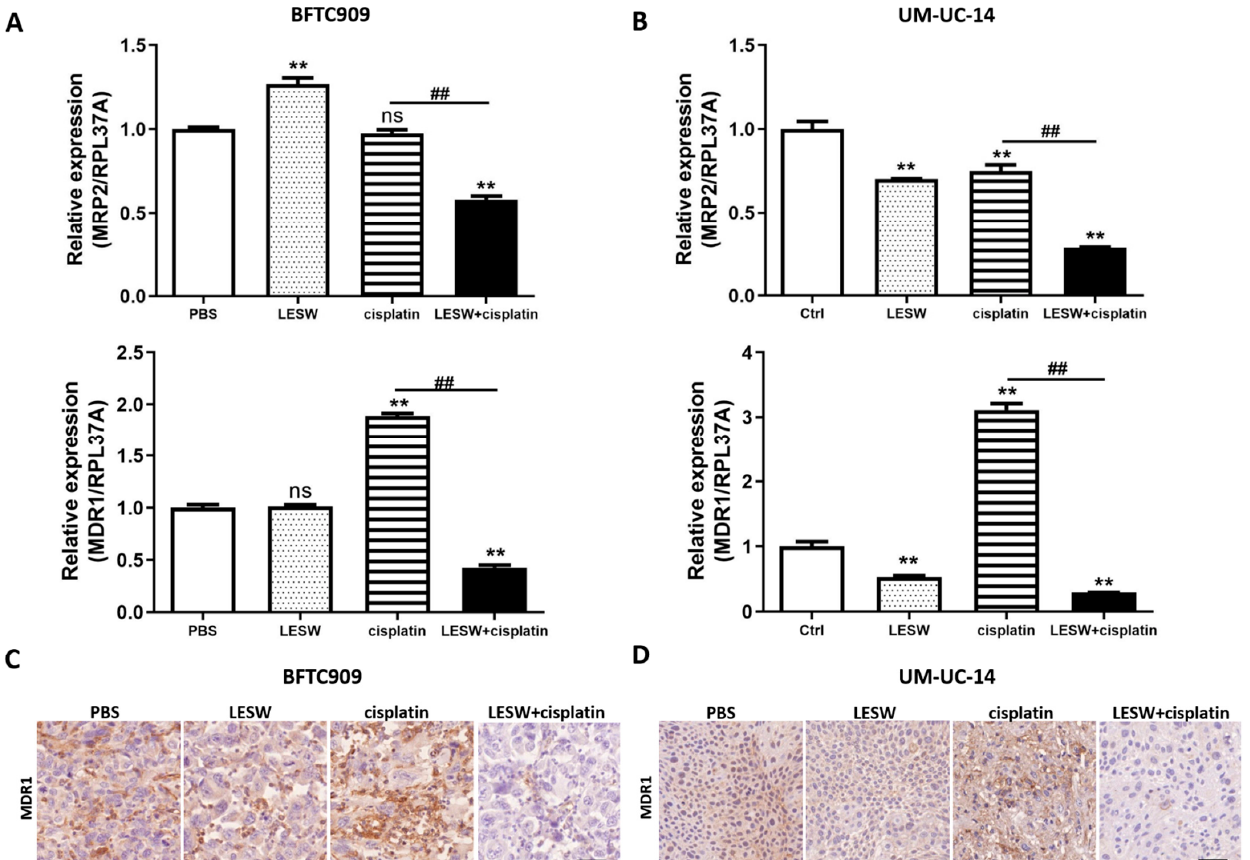
Figure 5. Combined treatment with LESW and cisplatin downregulated MDR1 expression in UTUC cell line xenograft models. ( A , B ) Quantitative polymerase chain reaction analysis of MRP2 and MDR1 expression in BFTC909 ( A ) and UM- UC-14 ( B ) xenografts. Error bars represent mean ± S.E.M. The statistical test performed was one-way-ANOVA, ** p < 0.01 versus control group; ns indicates no significance, ## p < 0.01 versus CDDP group. ( C , D ) Immunohistochemical imaging of BFTC909 ( C ) and UM-UC-14 ( D ) xenograft tumour tissue sections immunolabeled for MDR1. Scale bars indicate 40 µ